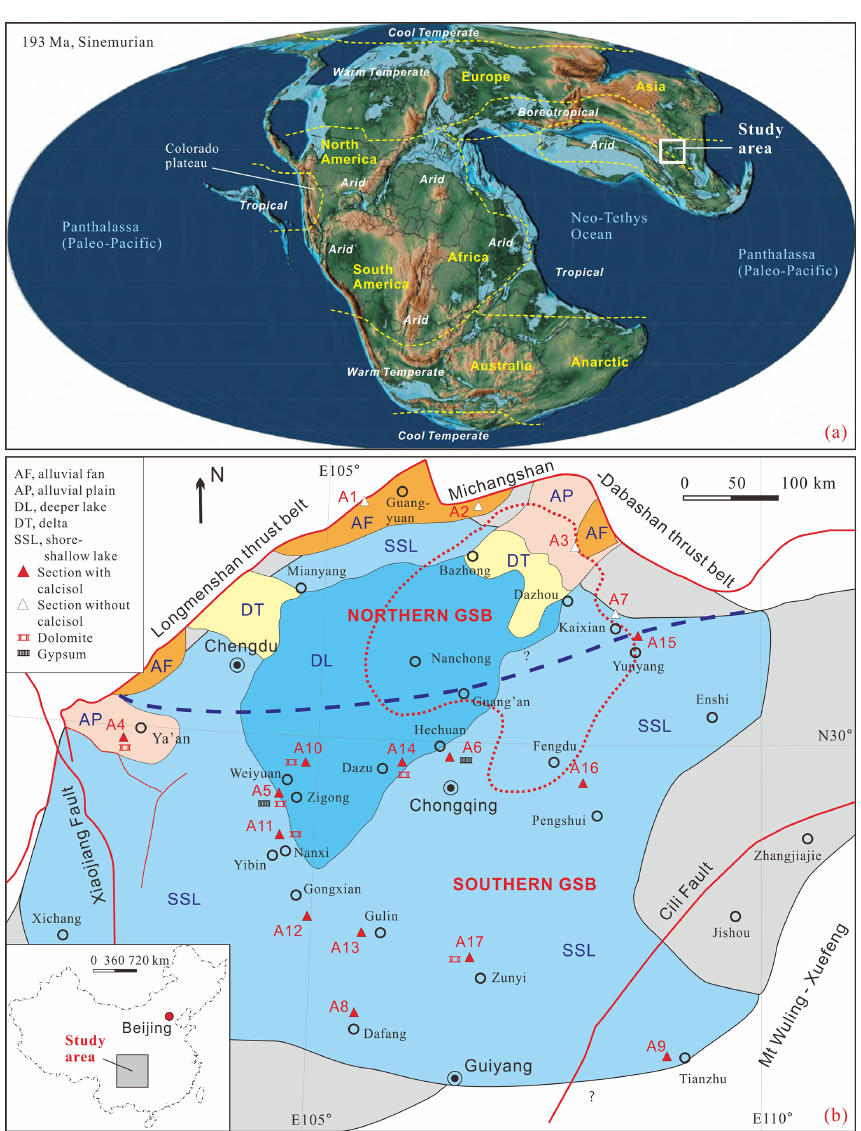
Figure 1. (a) Global Early to Middle Jurassic climate zones (Boucot et al., 2013) laid over an Early Jurassic ( ∼ 193Ma, Sinemurian) paleo- geographic map (Scotese, 2014). (b) Lithofacies paleogeographic sketch of the grand Sichuan paleobasin (GSB) in the early Early Jurassic (Zhenzhuchong and Dongyuemiao members) showing locations of the observed and analyzed sections and climate-sensitive sediments. The lithofacies paleogeographic map was composed and modified from Ma et al. (2009) and Li and He (2014). The blue area is the extent of the paleolake, estimated as ∼ 380000km 2 . The blue-gray region is the basin shape, estimated as ∼ 480000km 2 . The dotted red line en- circles the deeper lake area in the late Early Jurassic (Ma’anshan and Da’anzhai members). The black dashed line is the northern edge of Calcisol occurrence, which may separate the climate of the GSB into the northern and southern types. Triangles with numbers are locations of observed and analyzed sections: A1, Xiasi section, Jian’ge; A2, Puji section, Wangcang; A3, Shiguansi section, Wanyuan; A4, Shaping section, Ya’an (bed and thickness from Wen and Zhao, 2010); A6, Tanba and Maliuping section, Hechuan (bed and thickness from Wang et al., 2010); A7, Wenquan section, Kaixian (thickness from Wang et al., 2010). The location and source data of sections A5 and A8–A17 (climate-sensitive sediments) refer to Supplement Table